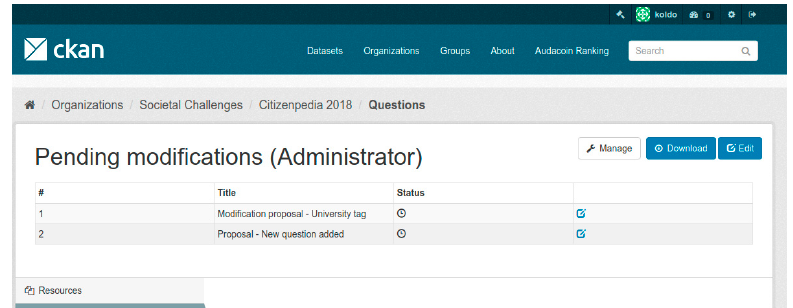
Figure 6. Screen showing modification revisions pending from administrator.